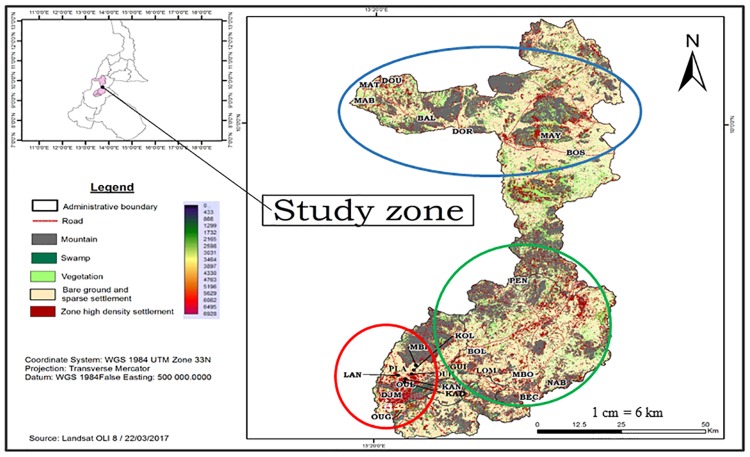
Map of North Cameroon showing study Health Districts (HDs) and clusters.The red chart encloses cluster of the Garoua HD (LAN: Lainde II; OUL: Ouro lawane; PLA: Plateau; DJM: Djamboutou; OUG: Ourogarga; KAN: Kanadi I; KAD: Kanadi II; MBI: Mbilga; OUH: Ouro housso; KOL: Kollere). The green chart encloses cluster of the Pitoa HD (PEN: Pene; BOL: Boulgou; LOM: Lombou; MBO: Mbolom; NAB: Nassarao-be; BEC: Be-centre; GUI: Guizigare). The Blue chart encloses cluster of the Mayo Oulo HD (DOU: Doumou; BOS: Bossoum; DOR: Dourbeye; MAY: Mayo oulo; MAB: Maboni; MAT: Matra; BAL: Bala).